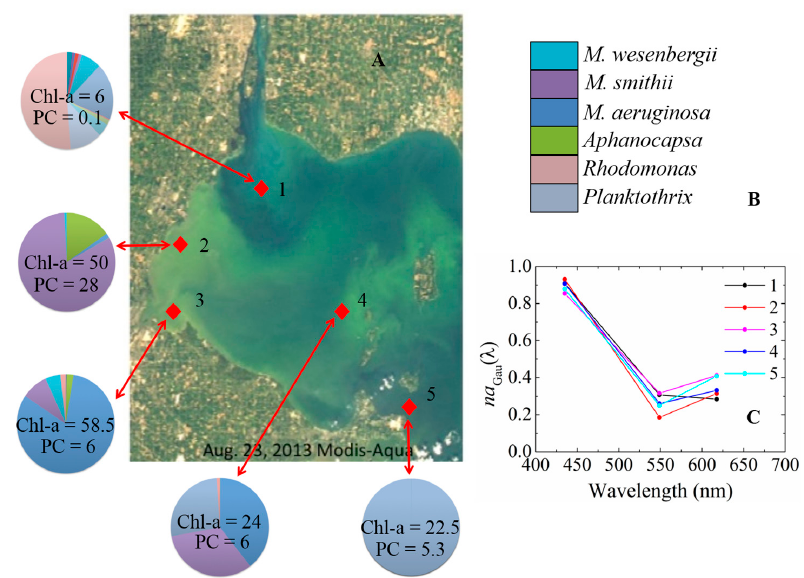
Figure 8. The different a Gau ( λ ) shapes corresponding to different locations and different species composition: ( A ) MODIS-Aqua true color image in western basin of Lake Erie on 23 August 2013; ( B ) cyanobacteria species composition in different locations of Lake Erie for August 2013, with the numbers for PC and Chl-a as the concentrations for these two pigments (mg ∙ m − 3 ), and M. as Microcystis ; and ( C ) the different spectral shapes of a Gau ( λ ) corresponding to different species composition in different locations in western basin of Lake Erie.